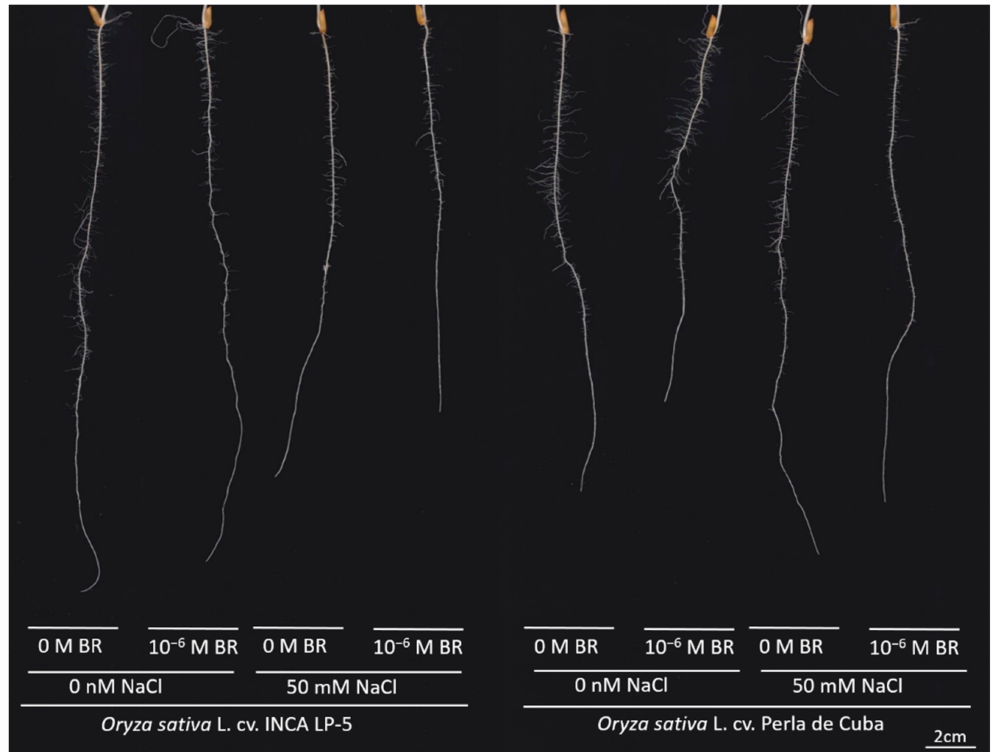
Figure 1. Representative root images of the two rice cultivars INCA LP-5 and Perla de Cuba after 7 days of growth in rolls with or without salt (NaCl) and 24-epibrassinolide (BR)